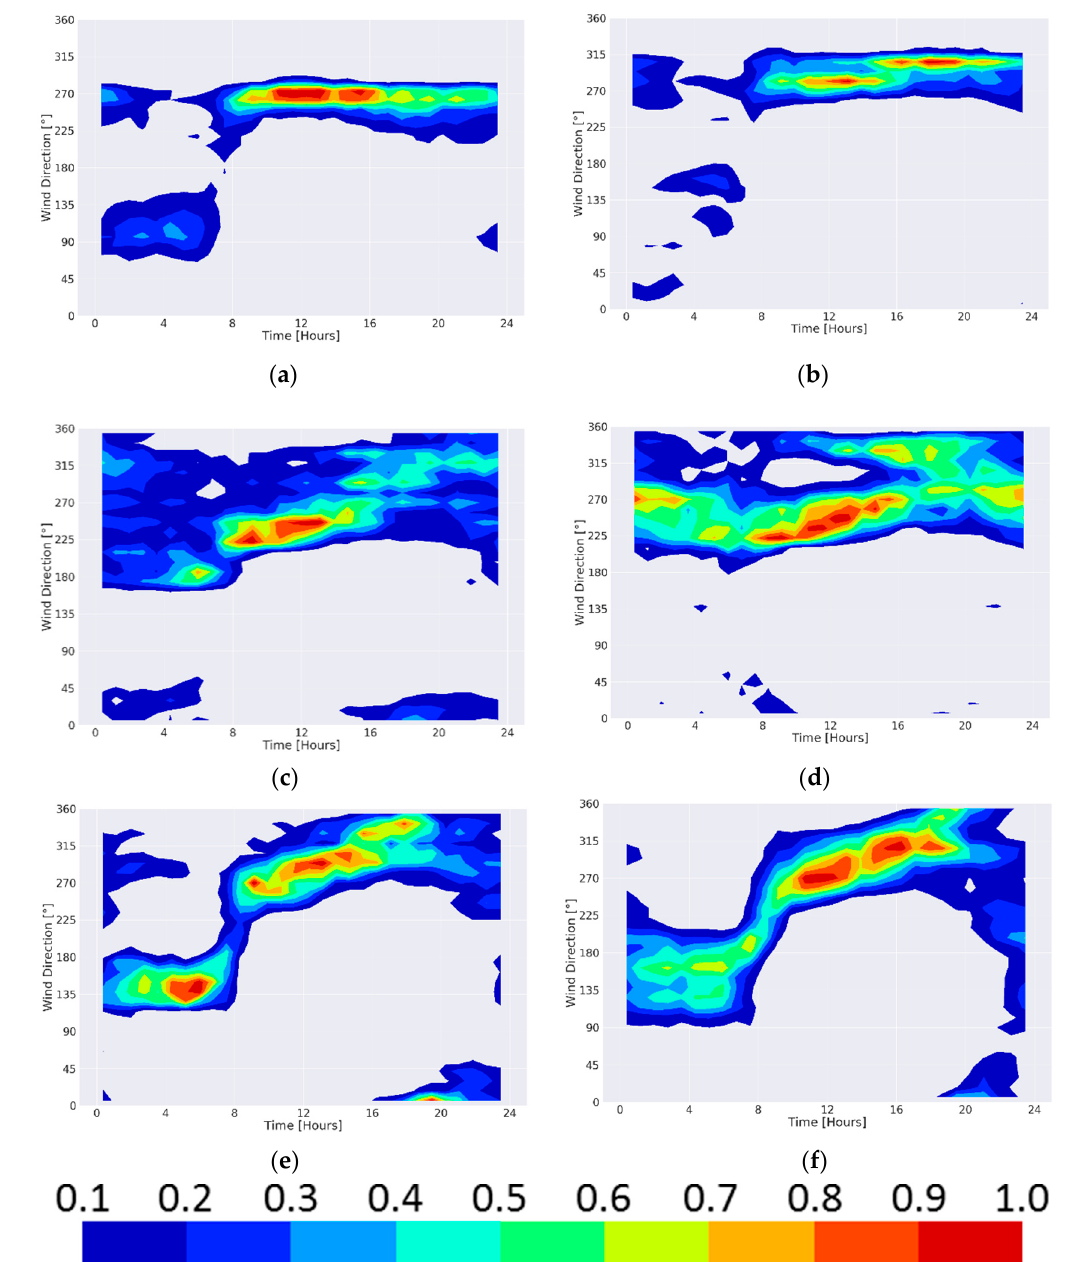
Figure 4. Nonparametric bivariate density of the wind direction of representative weather stations ( a ) Z4–Kiryat Bialik ( b )